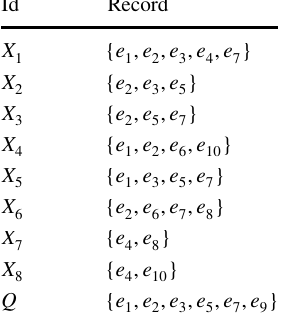
Table 1 A record dataset with eight records and a query Q